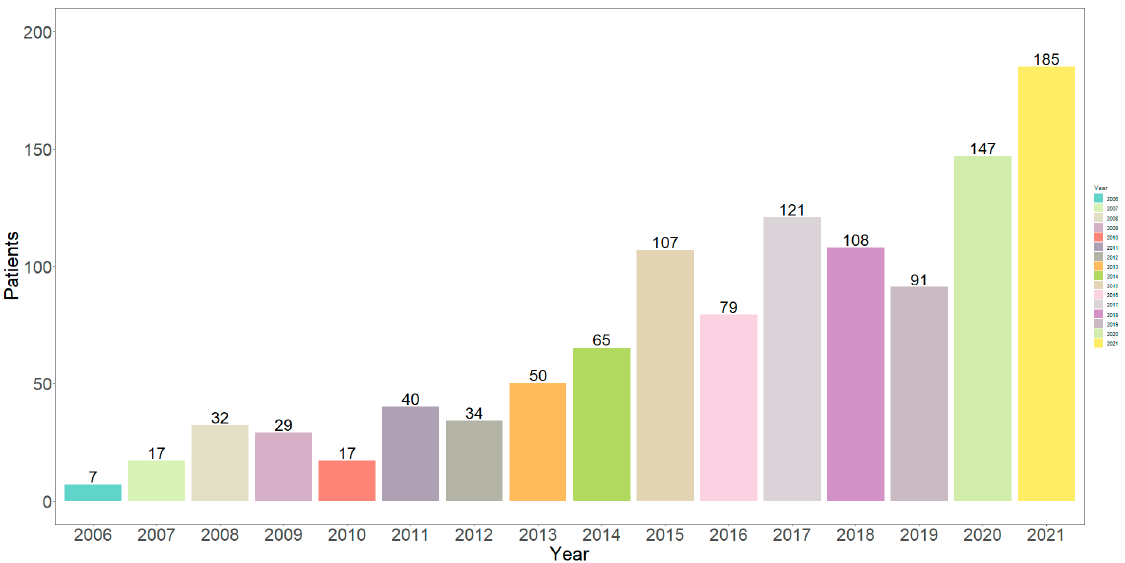
Figure 1. Number of pediatric orthopedics patients from 2006 to 2021.